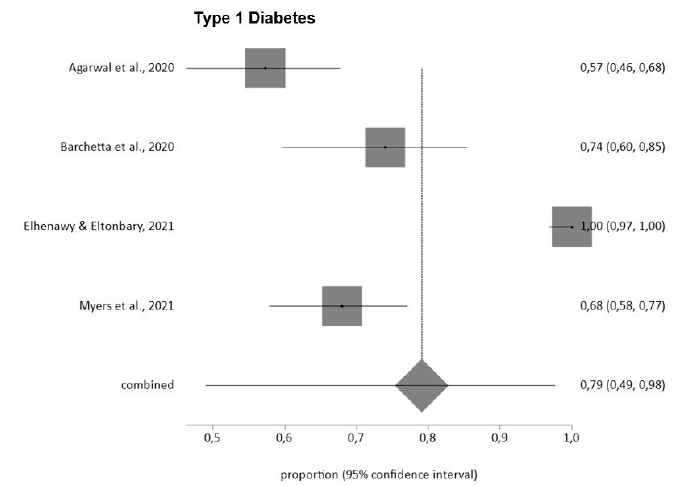
Figure 4. Prevalence of stress in DM patients during COVID-19 pandemic (PSS).